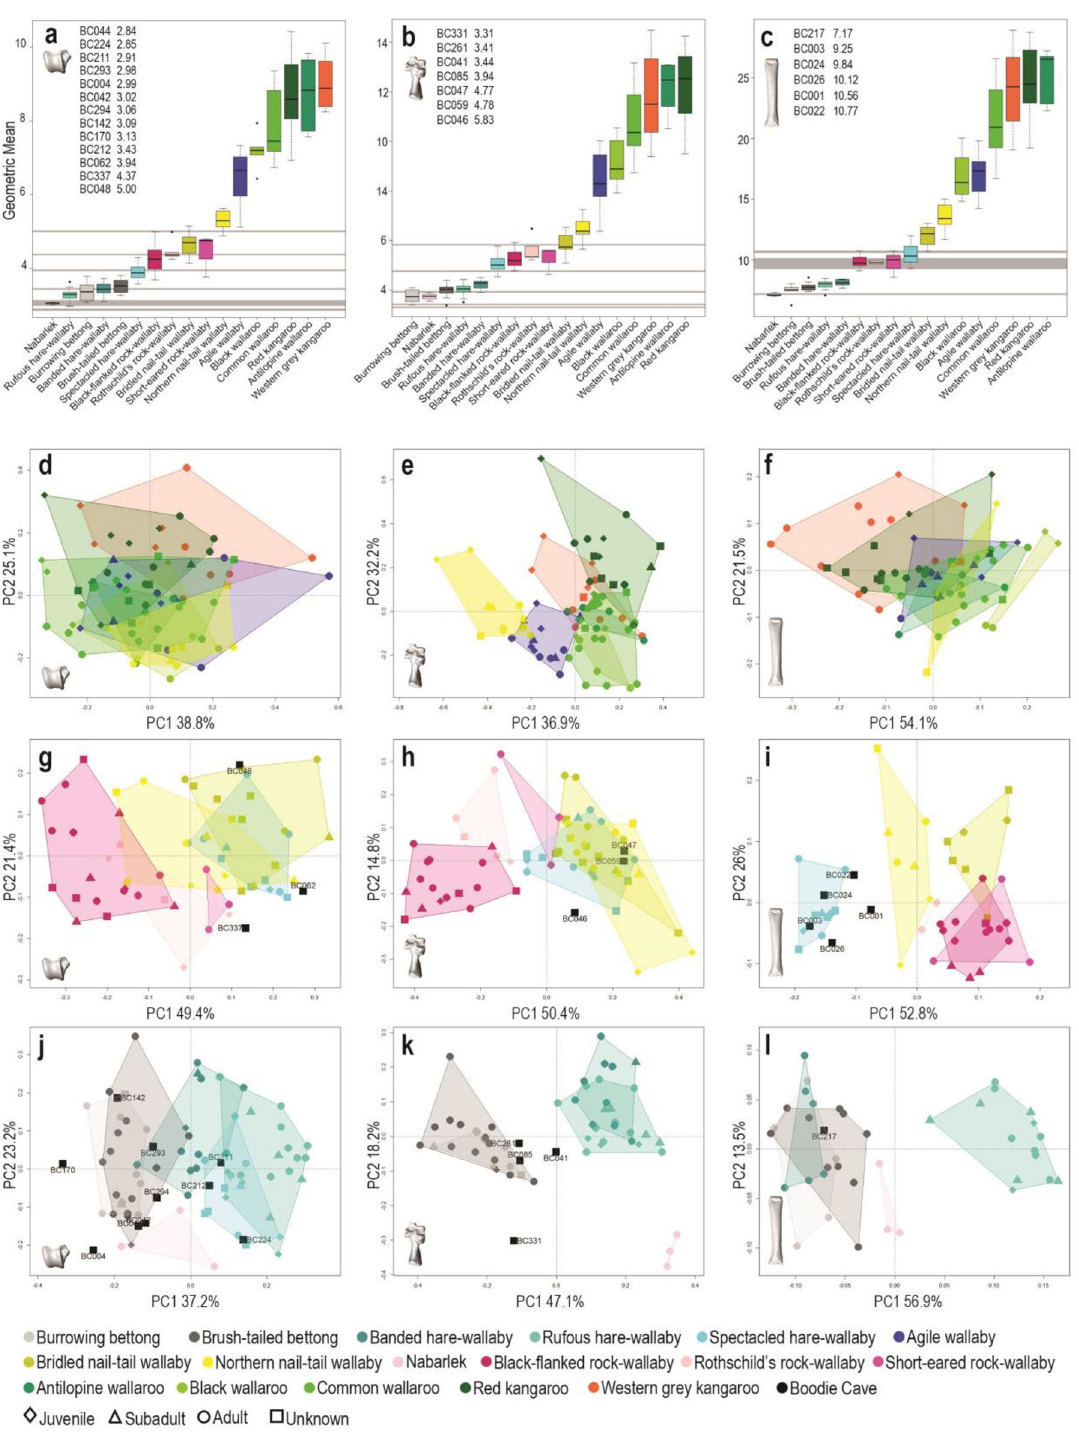
Figure 1. Size and shape of macropod pes bones by species. ( a–c ) Size of macropod astragali (left), calcanea (middle) and metatarsal IV (right) by species. Geometric mean of each archaeological specimen is listed from smallest to largest, grey bars indicate size range of archaeological specimens compared to training dataset; ( d–f ) PCA of large macropod astragali (left), calcanea (middle) and fourth metatarsal (right); ( g–i ) PCA of medium macropod astragali (left), calcanea (middle) and fourth metatarsal (right); ( j–l ) PCA of small macropod astragali (left), calcanea (middle) and fourth metatarsal (right). Figure generated with R (v.4.1.0) (www. cran.r- proje ct. org) and Adobe Indesign (v16.4) (www. adobe.